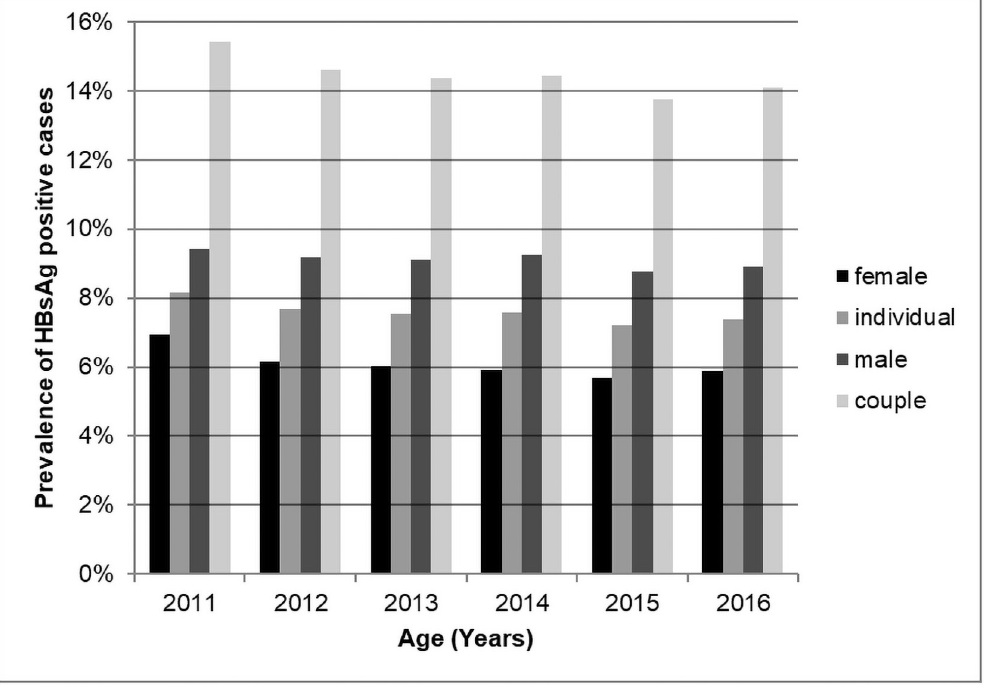
Fig 2. HBsAg prevalence by population and